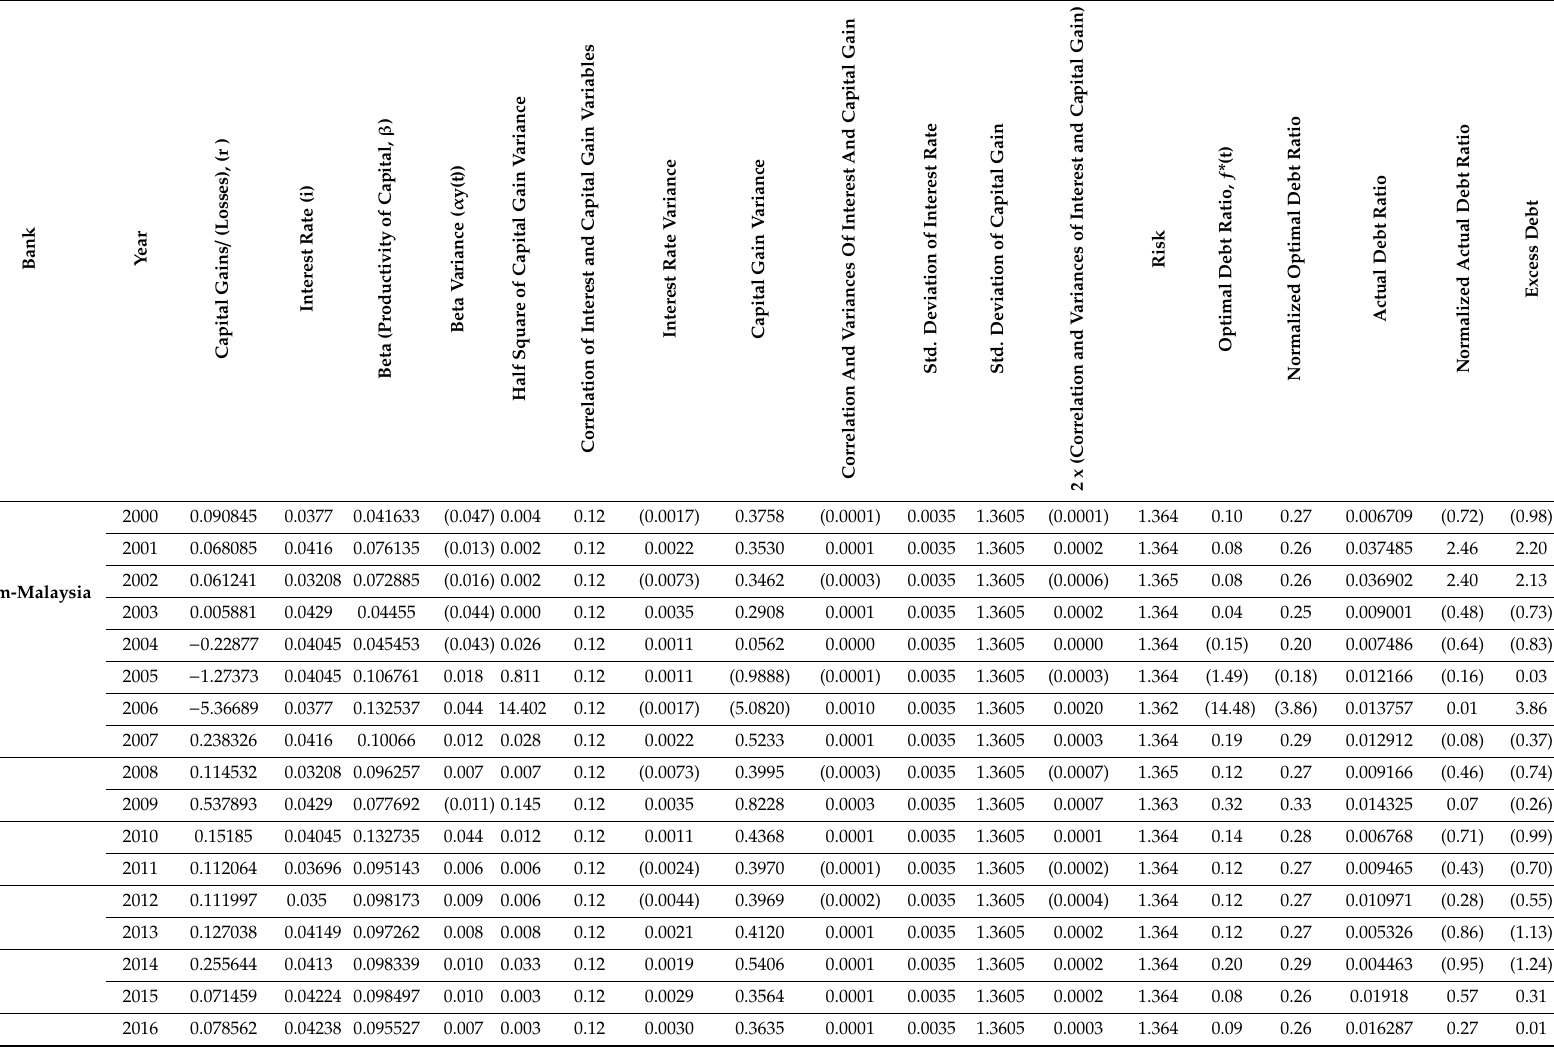
Table A12. Calculations of Optimal and Excess Debt: